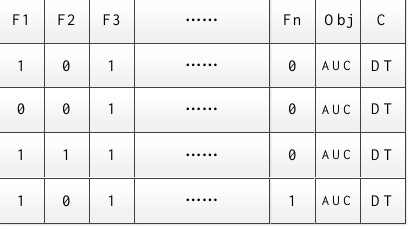
Figure 4. An example of the neighborhood feasible solutions.